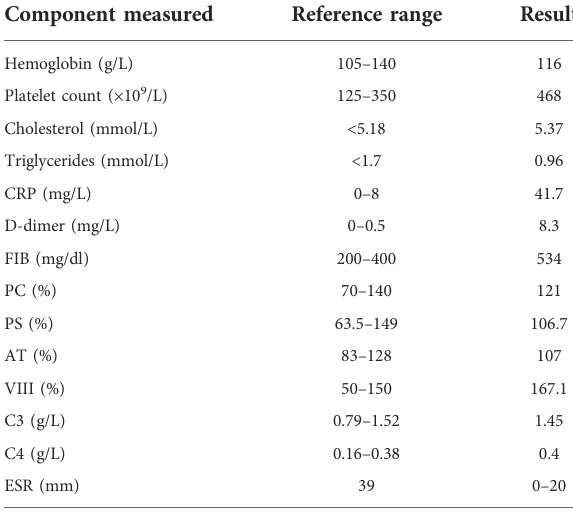
TABLE 1 Overall laboratory results (complete blood count, blood chemistry, coagulation function test, and immunological tests) of the